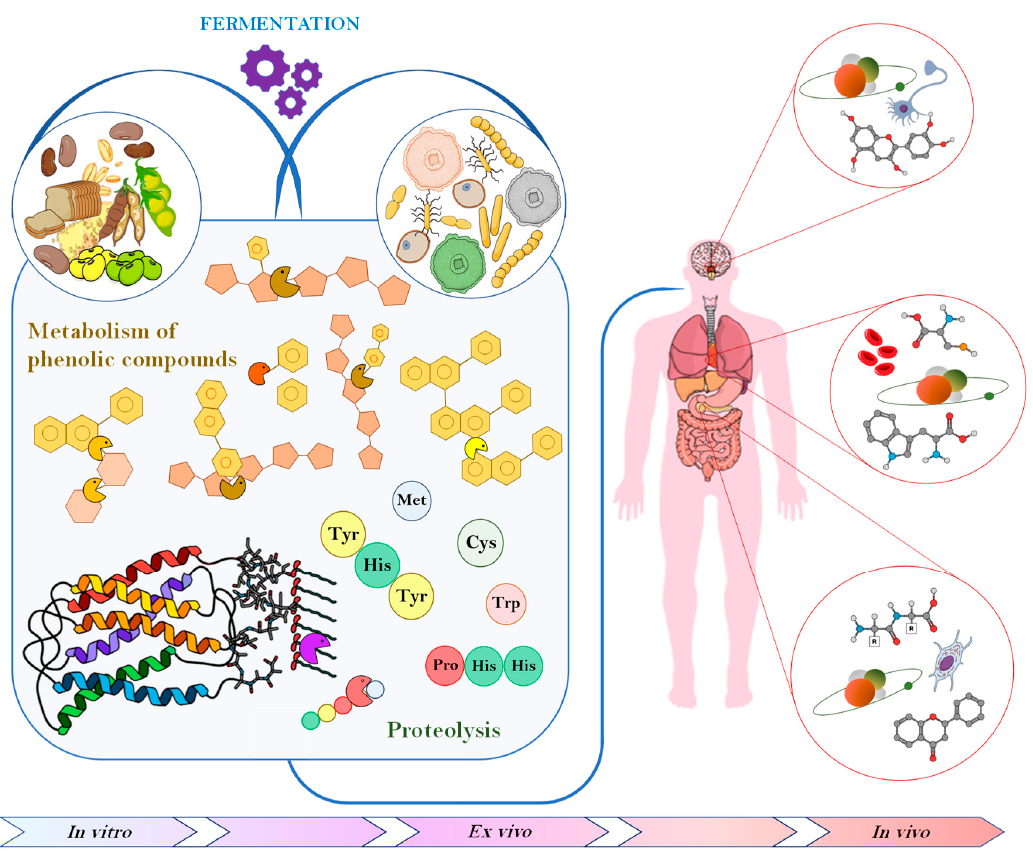
Figure 1. Schematic representation of the main effects of fermentation on food antioxidant compounds and consequent impact on human body.